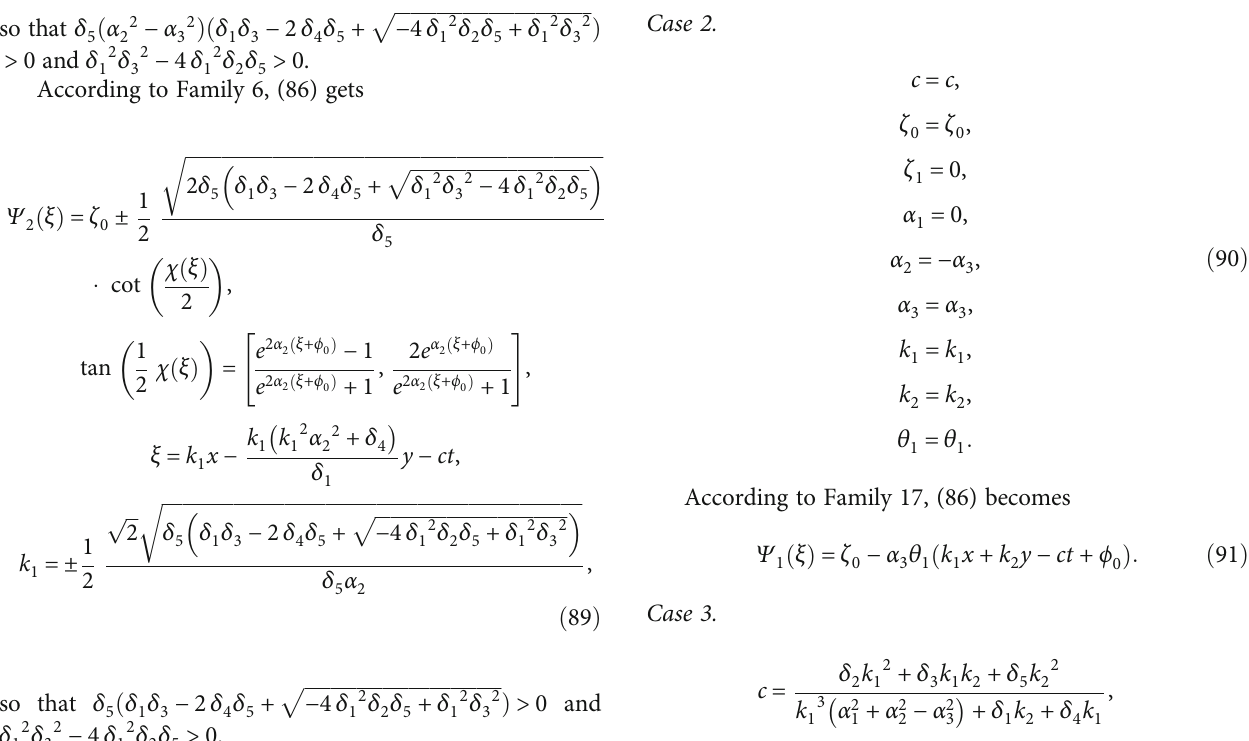
Figure 13: Plot evolution of cross-kink waves (51) utilizing values a = 2, δ = 1 : 3, δ = 2, Ψ = 1, t = 10 and (a) 3D plot, (b) density plot, and (c) contour 1 : 3, δ 3 4 5 0